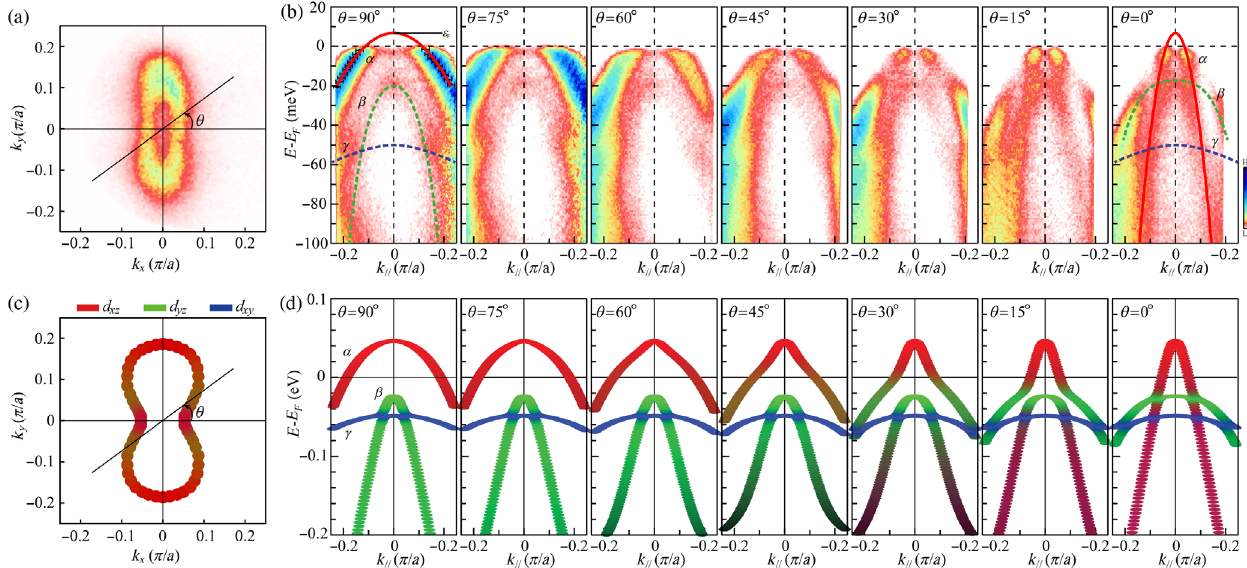
FIG. 3. Band structure of FeSe along different momentum cuts and their orbital nature. (a) Definition of the momentum cuts across the Γ point by the Fermi surface angle θ . (b) Measured band structure along different momentum cuts varying from θ ¼ 90 ° (vertical cut, leftmost panel) to θ ¼ 0 ° (horizontal cut, rightmost panel). Three bands are observed, marked as α , β , and γ in the θ ¼ 90 ° and θ ¼ 0 ° panels. The α band is well fitted by a parabolic curve (red line) which gives a Fermi energy ε F of ∼ 6 . 7 meV above the Fermi level. The effective mass for different momentum cuts can be obtained from such a parabolic fitting. The dashed green and blue lines are guides to the eye for the β and γ bands, respectively. (c) The calculated Fermi surface of FeSe around Γ point in the nematic state. (d) The calculated band structure along different momentum cuts defined by the Fermi surface angle θ in (c). In panels (c) and (d), the d xz , d yz , and d xy orbital components are represented by red, green, and blue colors,